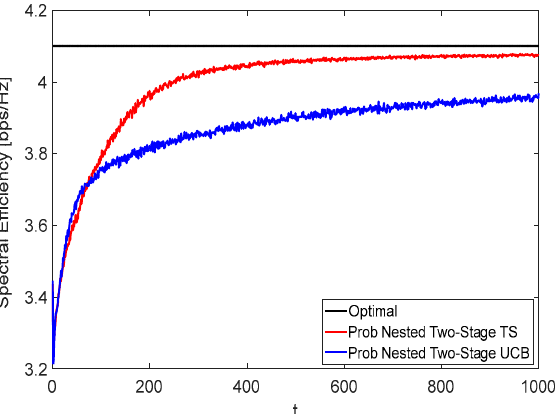
Figure 8. Spectral efficiency convergence at no blockage using K = N = M = 16.